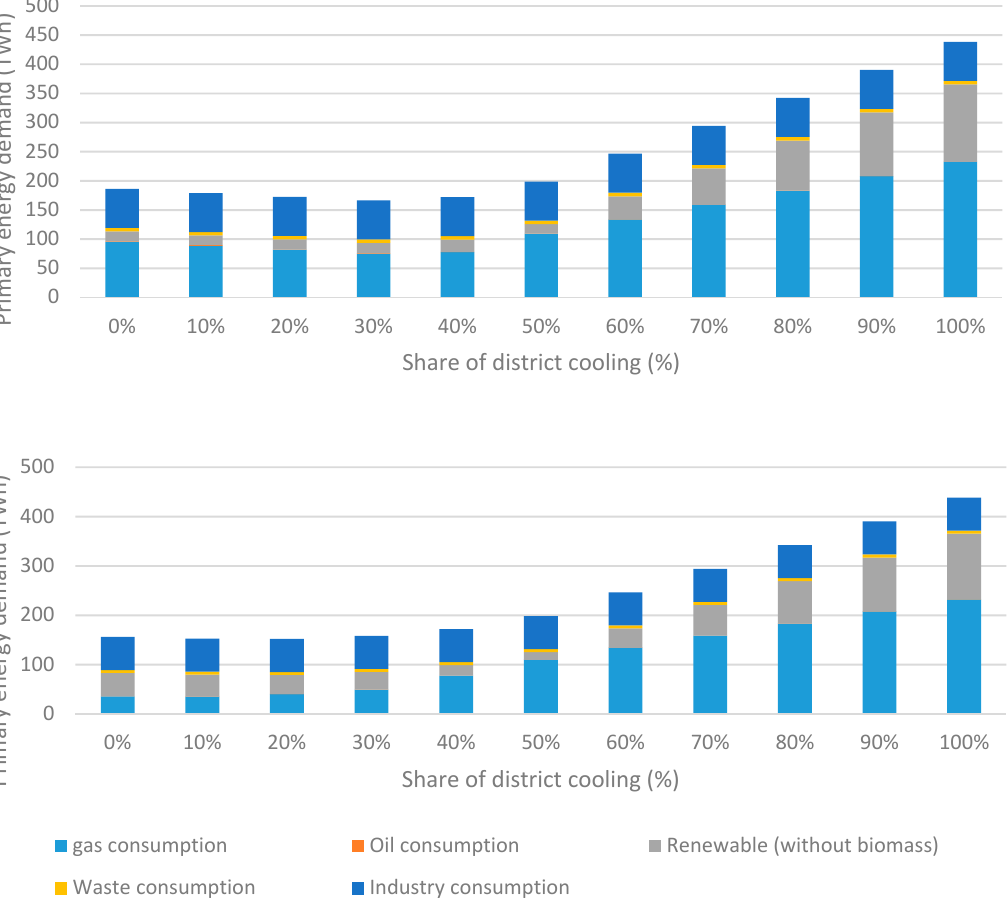
Figure 1. Comparison of the total socio-economic costs in PV constrained and unconstrained PV scenarios.